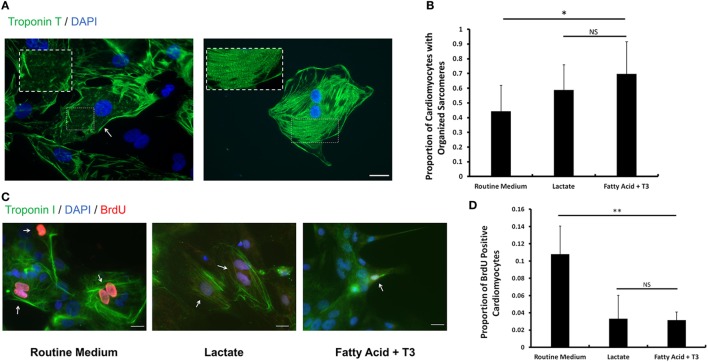
Fatty acid and T3 treatment enhances sarcomere formation and decreases proliferative activity in human pluripotent stem cell (hPSC)-derived cardiomyocytes. (A) Representative photomicrographs showing cardiac Troponin T (green) in hPSC-derived cardiomyocytes with unorganized (left panel) and organized (right panel) sarcomeres. Magnification of the sarcomeres is shown in the white dash line boxes. Nuclei are stained with DAPI (blue). The white arrow indicates the cardiomyocyte with undeveloped sarcomeres cultured in the routine medium. The scale bar is 200 µm. (B) The proportion of cardiomyocytes with organized sarcomeres from the lactate-supplemented condition, the fatty acid + T3-supplemented condition and the routine culture condition. n > 1300 cells in each group. #P < 0.05; *P < 0.01. (C) Fatty acid and T3-treated cardiomyocytes demonstrate lower proliferative activity. Bromo-2′-deoxy-uridine labeling was performed. Cells were co-stained with cardiac Troponin I antibody (green), DAPI (blue), and BrdU antibody (red). Representative images were taken from cells cultured in control medium, in fatty acid + T3 medium, and in lactate medium. The white arrows denote BrdU-positive cardiomyocyte nuclei. The scale bar is 20 µm. (D) Fatty acid + T3 treatment and lactate treatment are associated with a significantly lower percentage of BrdU-positive cardiomyocytes than the control condition. Approximately 8,000 cells were counted in each group. NS, no significant difference; **P < 0.001.